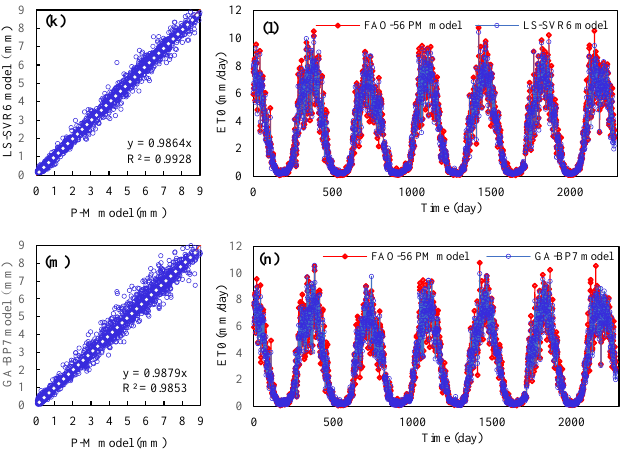
Figure 6. Comparisons of the daily reference evapotranspiration ( ET 0 ) values calculated by the FAO-56 PM method vs. modelled data via the optimal reference evapotranspiration model under different input combinations during the testing phase. LS-SVR1 model correlation diagram ( a ), LS-SVR1 model measured value and simulated value ( b ); RF2 model correlation diagram ( c ), RF2 model measured value and simulated value ( d ); LS-SVR3 model correlation diagram ( e ), LS-SVR3 model measured value and simulated value ( f ); LS-SVR4 model correlation diagram ( g ), LS-SVR4 model measured value and simulated value ( h ); GA-BP5 model correlation diagram ( i ), GA-BP5 model measured value and simulated value ( j ); LS-SVR6 model correlation diagram ( k ), LS-SVR6 model measured value and simulated value ( l ); GA-BP7 model correlation diagram ( m ), GA-BP7 model measured value and simulated value ( n ).